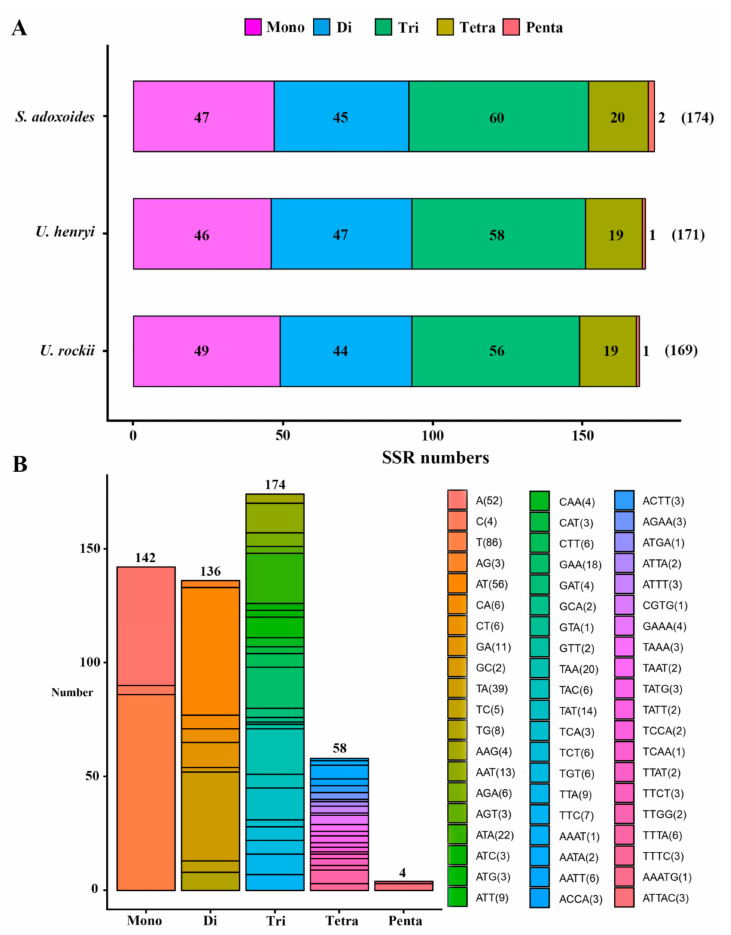
Figure 3. Analysis of simple sequence repeats (SSRs) in chloroplast genomes of the three species. ( A ) Number of different SSR types detected in each species; ( B ) type and frequency of each identified